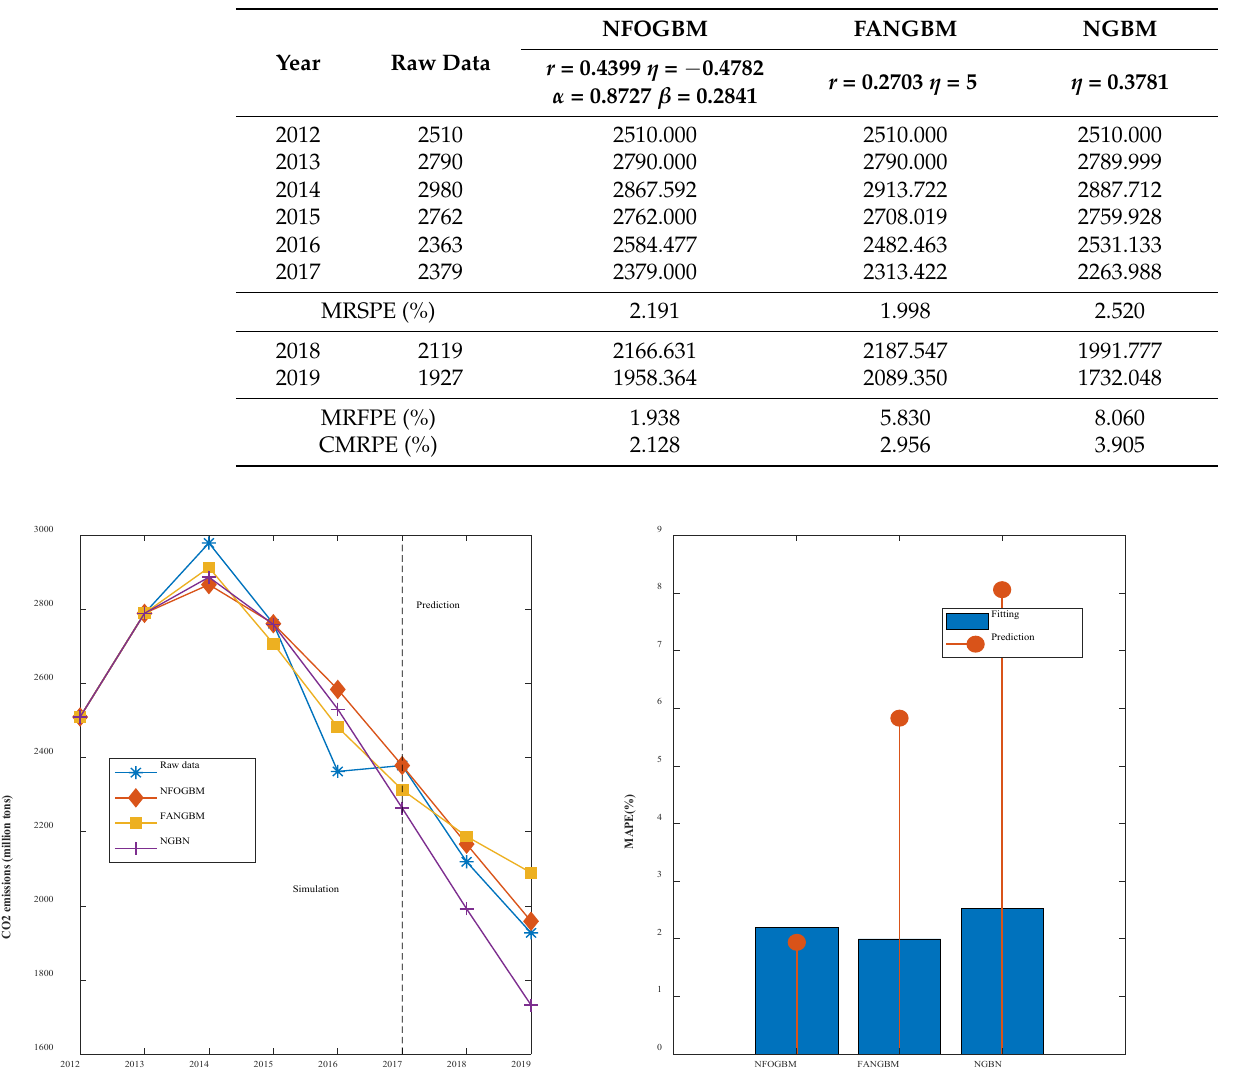
Table 6. Modeling results for NMMD.